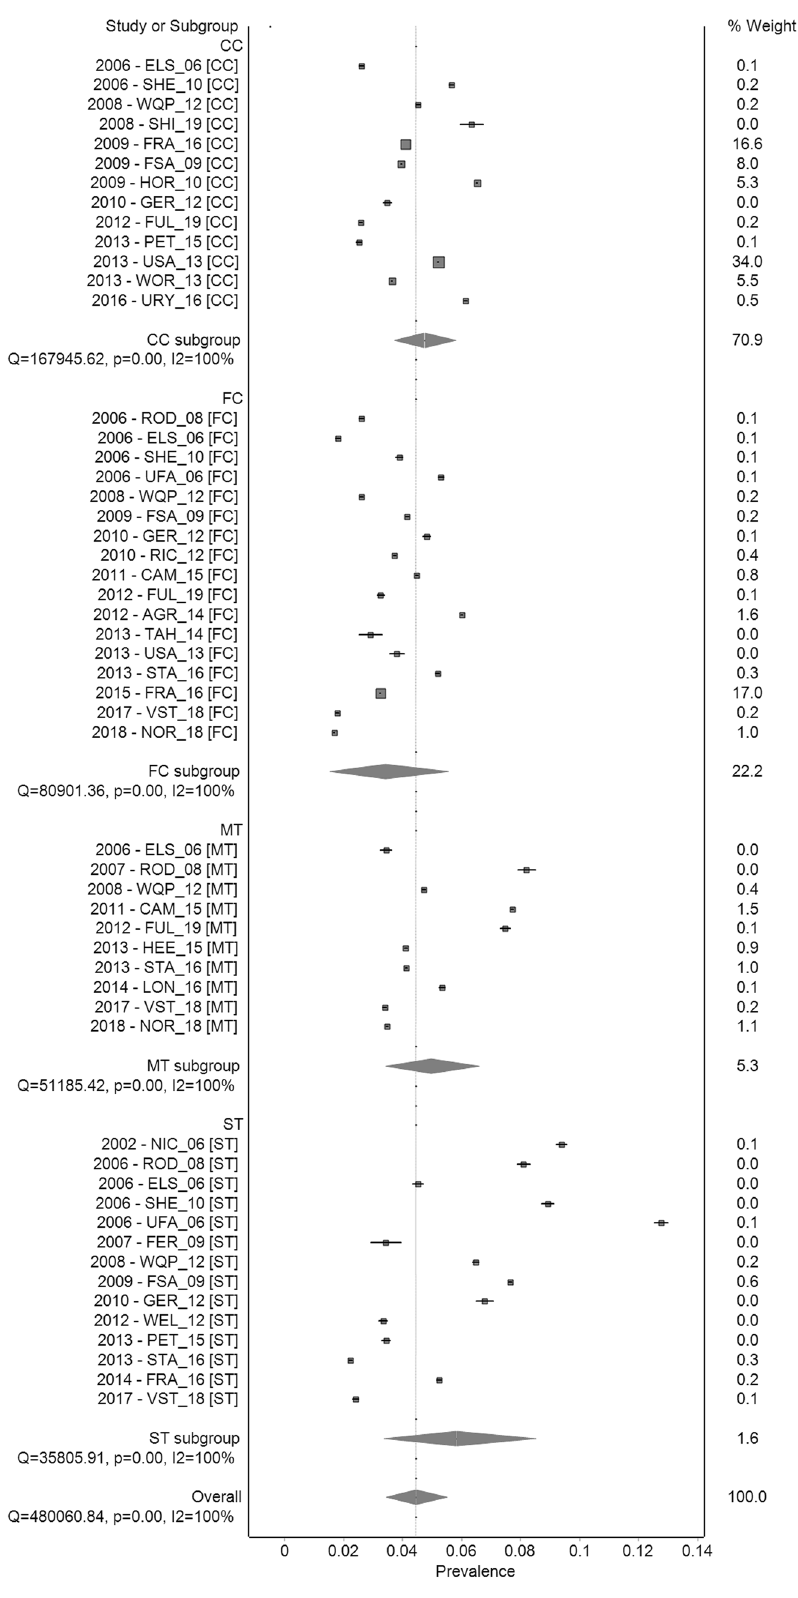
Figure 3. Forest plot of mean cumulative mortality of commercial layer flocks (2000–2020). Cumulative mortality at 60 weeks in different commercially managed indoor systems: conventional cages (CC), furnished cages (FC), single-tier (ST) and multi-tier (MT) aviaries, ordered by the mid-year of data collection. Each square represents individual estimates from each data source. Square sizes represent the weight derived from the meta- analysis (see Methods). Pooled estimates (weighted averages) are represented by